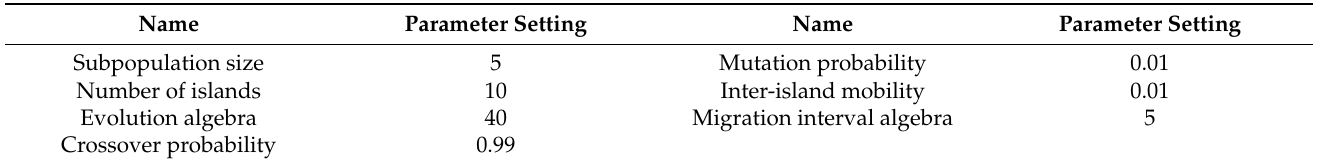
Table 2. Parameter configuration settings for